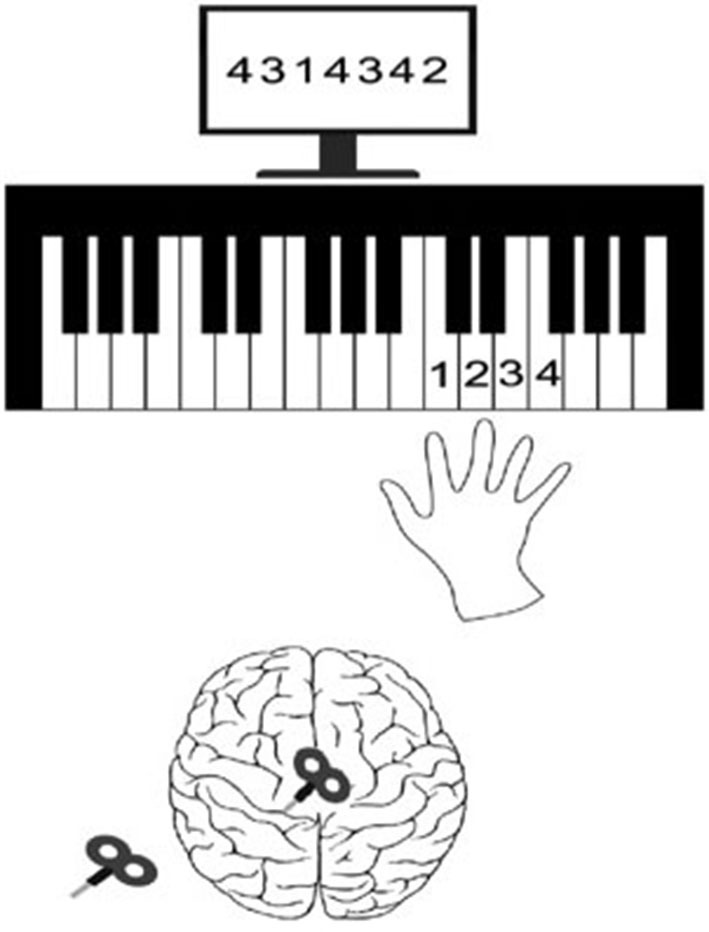
Experimental setup. A 7-digit sequence of numbers, which was a combination of 1, 2, 3, or 4 in a random order, was displayed on the monitor for 2500 ms. Participants were instructed to repeatedly push the 1, 2, 3, or 4 numbered buttons as accurately and quickly as possible with their right fingers. Each button was labeled with a number representing the finger: 1, 2, 3, and 4 represented the index, the middle, the ring, and the little finger, respectively. This task was repeated before and after high frequency rTMS on randomly assigned M1 or SMA. A week later, the same task was repeated again before and after rTMS on the other area at this time (cross- over study design).